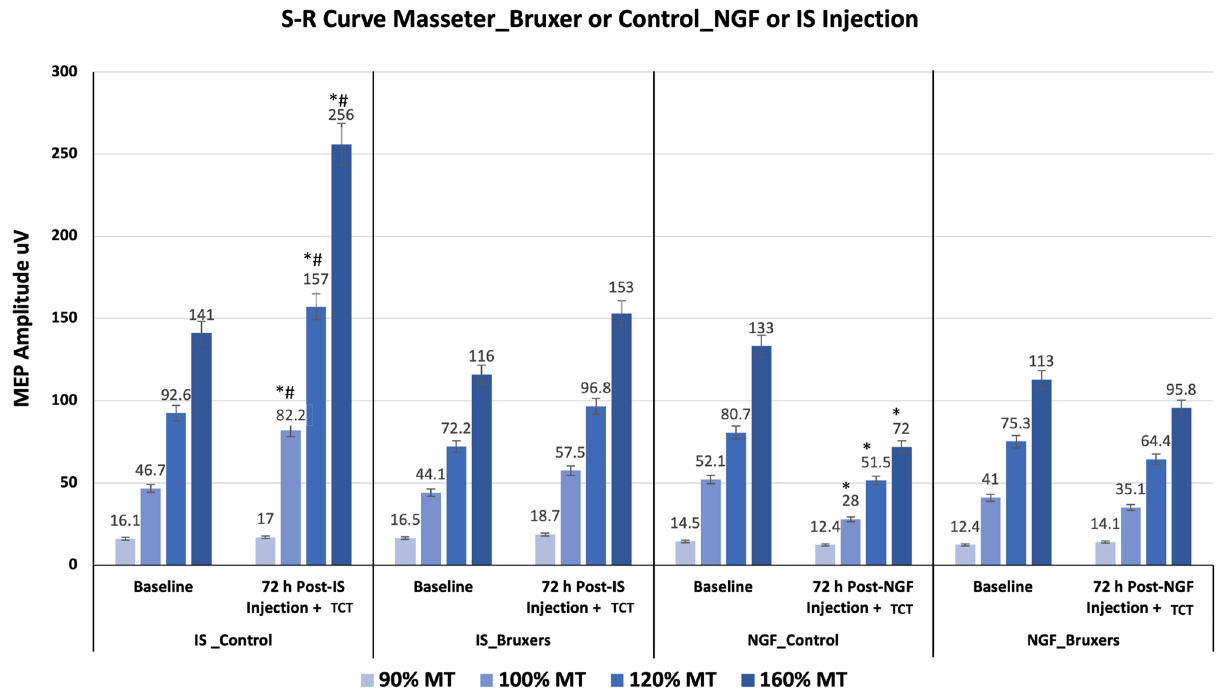
Figure 1. S–R curves from masseter MEP elicited by TMS at two-time points: baseline and 72 h post-injection and a TCT. (*) Indicates significant higher (IS_Control) and lower (NGF_Control) MEP amplitude within- group differences comparing values (mean and SEM) at baseline and post-injection and TCT ( P < 0.05). There were no significant MEP amplitude within-group differences for bruxer participants (IS_Bruxer and NGF_Bruxer groups) regardless they had received IS or NGF ( P > 0.05). (#) indicates significant higher MEP amplitude differences between ‐ group (Intensity, at 90, 100, 120 and 160% MT), (P < 0.05). Tooth clenching task